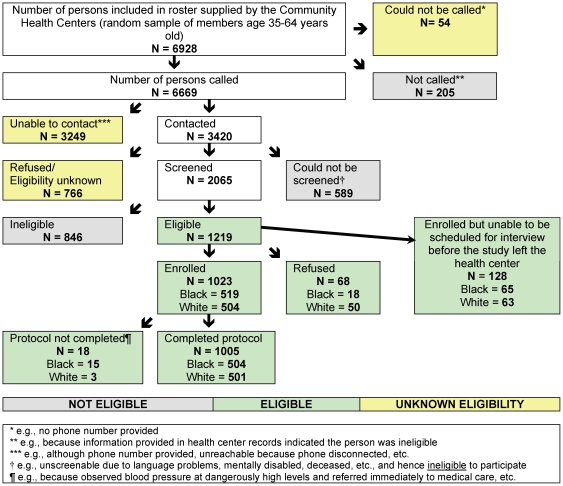
Study enrollment: My Body My Story (Boston, MA, 2008–2010).